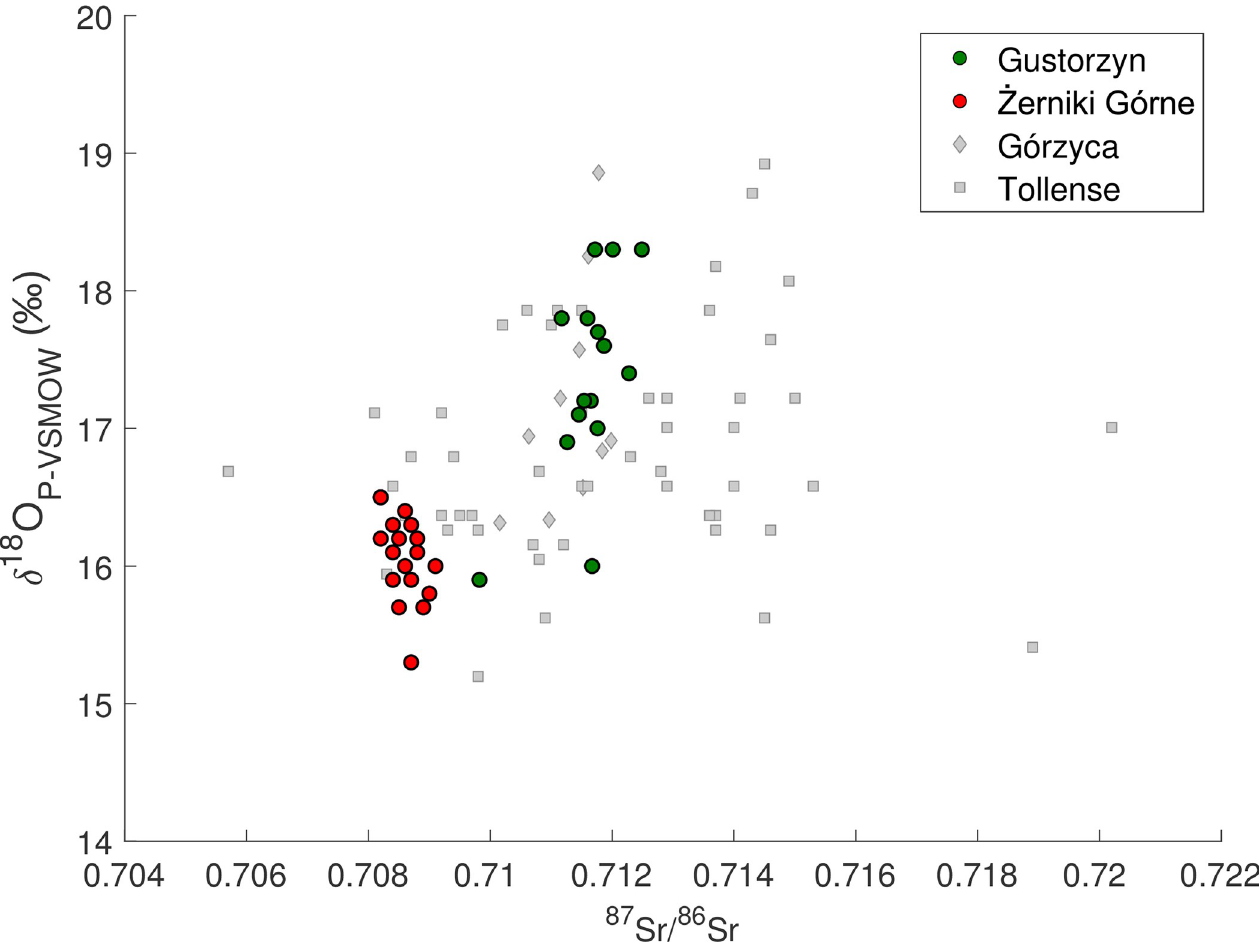
Fig 7. Strontium ( 87 Sr/ 86 Sr) and oxygen ( δ 18 O P-VSMOW ) isotope composition in human remains from Gustorzyn and Ż erniki Go´rne (this study), and from Middle-Late Bronze Age sites in Go´rzyca [39] and Tollense [14].